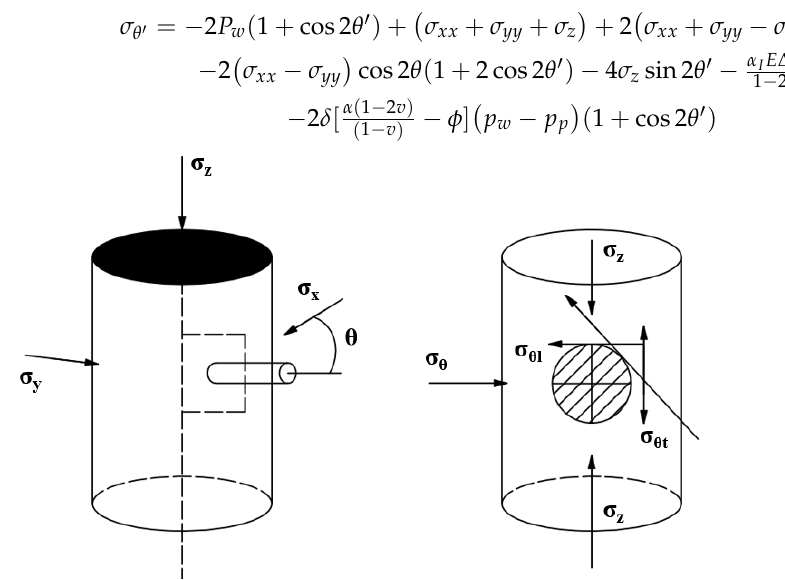
Figure 2. Perforation geometric model and stress redistribution diagram.